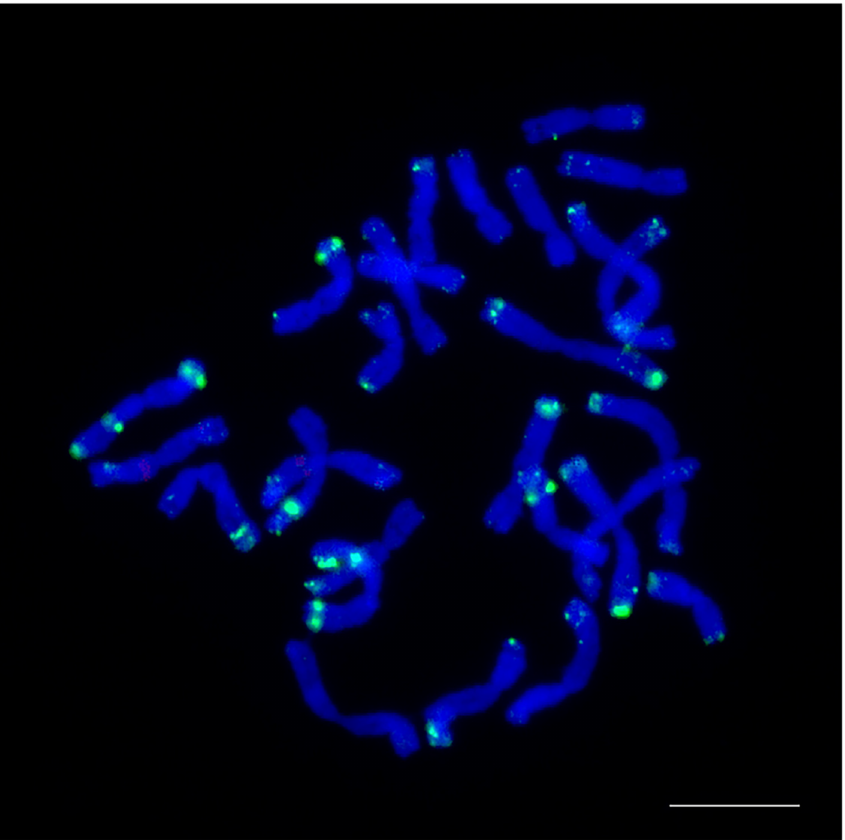
Figure 10. Localization of the CL131 tandem repeat on the Aegilops crassa AE 742 metaphase chromo- somes using fluorescence in situ hybridization. Green signals indicate the chromosomal localization of the CL131 tandem repeat. The bar indicates 10 µ